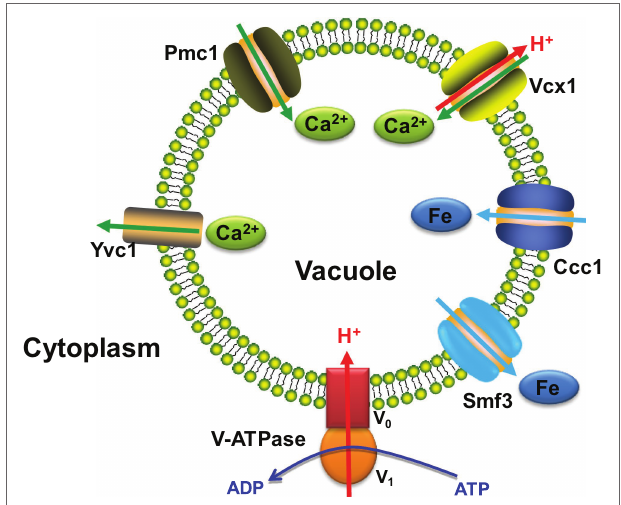
FIGURE 1 | The major ion transporters located on the vacuolar membrane in C. albicans . V-ATPase, pumps H + from the cytoplasm to the vacuole. Yvc1, transports Ca 2+ from the vacuole to the cytoplasm. Pmc1, transports Ca 2+ from the cytoplasm to the vacuole. Vcx1, the Ca 2+ /H + exchanger. Ccc1, the vacuolar iron importer. Smf3, the vacuolar iron exporter. The arrows represent the direction of ion